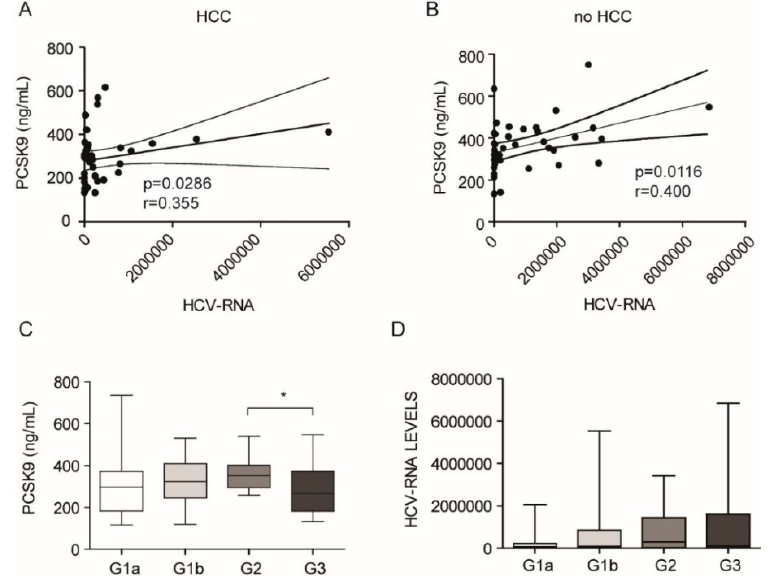
Figure 1. HCV infection is associated with higher levels of circulating PCSK9, irrespectively from the presence of HCC. ( A ) Whole HCV+ population showed increased PCSK9 plasma levels compared to HCV- patients; ( B ) Plasma PCSK9 was found higher in HCC HCV+ subgroup compared to HCC HCV- subgroup; ( C ) HCC HCV+ patients showed a decrease in PCSK9 plasma levels compared to no HCC HCV+ patients; ( D ) HCC HCV- subpopulation showed a higher viral titer compared to HCC HCV+ group. * p < 0.05; ** p < 0.01; *** p < 0.001.